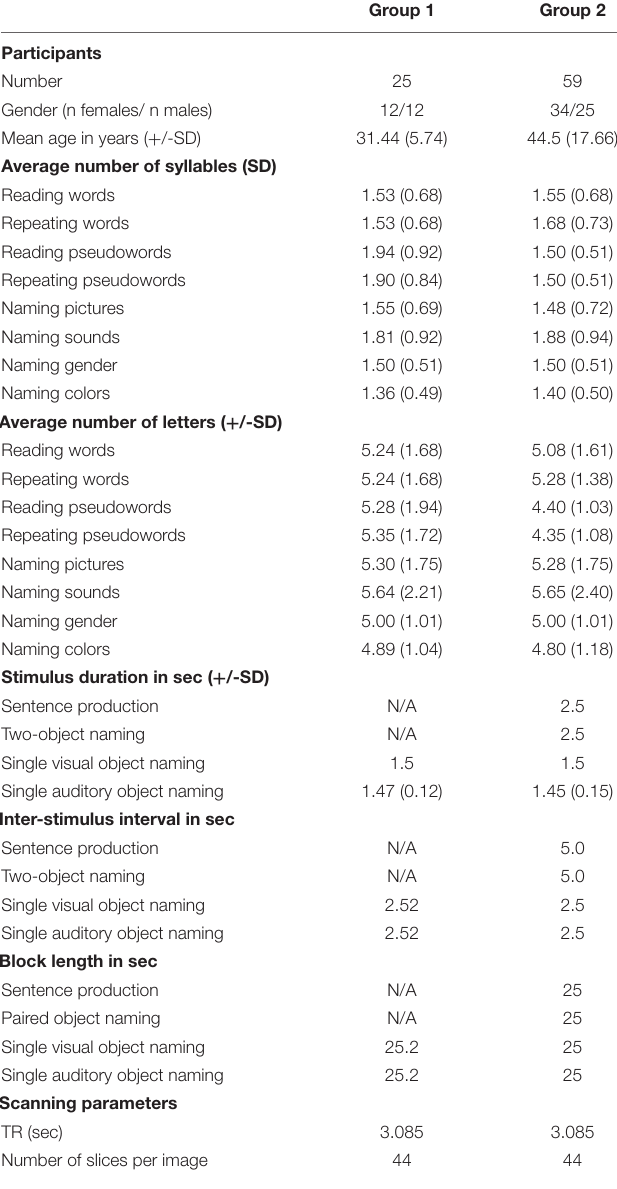
FIGURE 3 | Regions of interest. Sagittal slices (left x = –54, right x = –48) showing the group-level SPM{t} map for language regions of interest overlaid on a standard structural template in MNI space at p < 0.05 corrected for multiple comparisons. The SPM{t} map was generated using data from Group 1 only. Green = temporal regions of interest, Red = frontal regions of interest (see Table 2 for